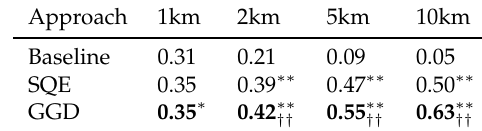
Table 2: MAP (reported to two decimal places) for spatial queries. Symbols * and ** denote a significant difference (respectively p < 0 . 05 and p < 0 . 01 , Students T-test) compared with Baseline. Similarly symbol † denotes a significant difference with